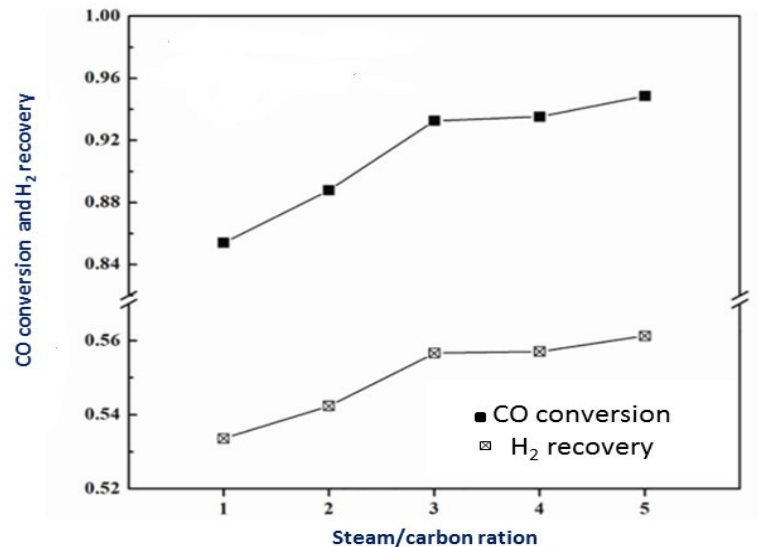
Figure 4. CO conversion and H 2 recovery (at the steady-state) as a function of the steam/carbon ratio [73].Tsotsis and coworkers prepared an ultra-permeable palladium membrane via ELP method, and it was used for hydrogen production using the WGS process [74]. A commercial Cu/Zn has been used as a catalyst. The authors found that increasing the feed pressure decreased the purity of the hydrogen owing to an increased driving force through the membrane for all the gas species. In addition, the membrane exhibited good stability for one month, and the change in H 2 permeance was equal to 6%. A complete CO conversion and an H 2 recovery of 90% have been obtained at 300 °C and 4.6 bar. Other results present in the open literature with metal membrane reactors in WGS are presented in Table 2. Table 2. Metal membrane reactors are applied in WGS process. Membrane